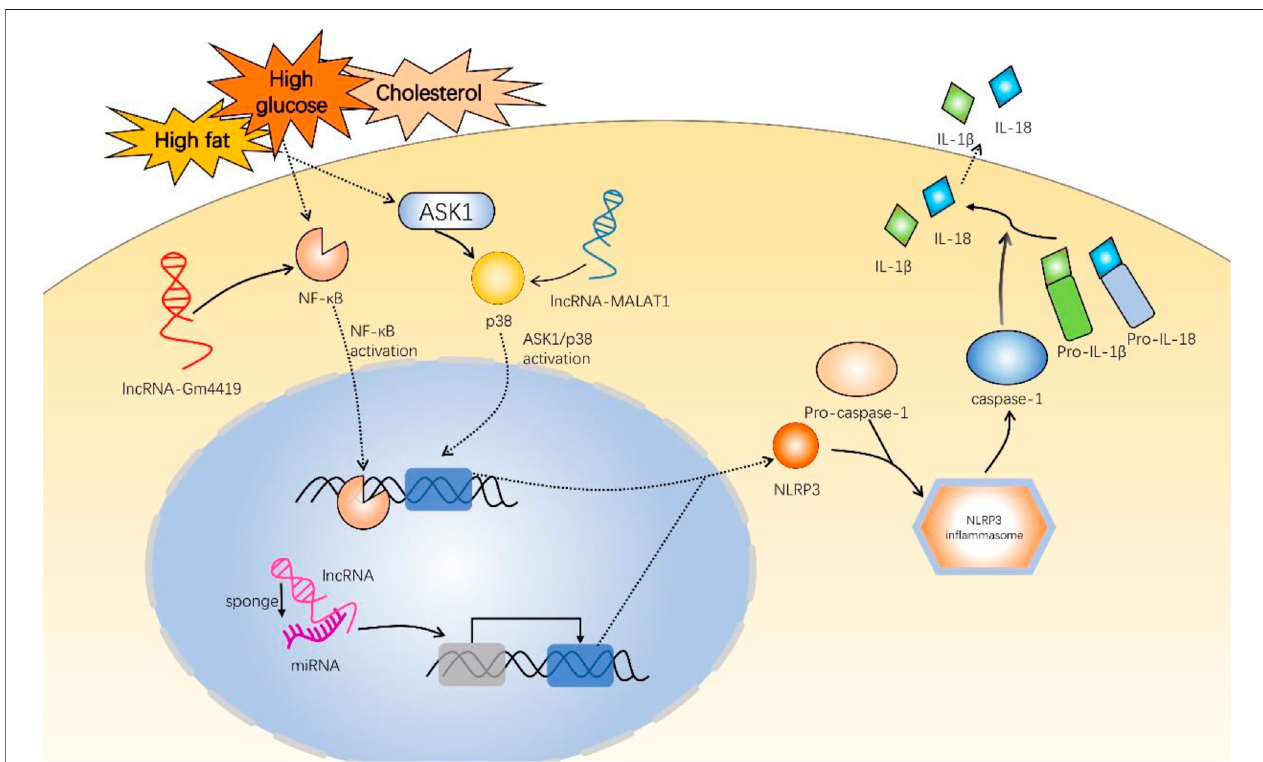
FIGURE 2 | Mechanisms of long non-coding RNAs involved in in fl ammatory responses of diabetic complications via NLRP3 in fl ammasome. These experiments used high-glucose induction to establish diabetic mouse models. LncRNA-Gm4419 activates NF- κ B pathway to upregulate NLRP3 expression in DN. LncRNA- MALAT1 activates ASK1/p38 pathway to upregulate NLRP3 in DR. In addition, most lncRNAs, such as ANRIL, Kcnq1ot1, NEAT1, HCP5, SNHG16, H19, and HCG18 promote or inhibit NLRP3 expression by sponging miRNA and regulating downstream target genes. NLRP3 and pro-caspase-1 are indispensable to NLRP3 in fl ammasome assembly. NLRP3 in fl ammasome activates pro-caspase-1 into caspase-1, promoting IL-1 β and IL-18 generation. NF- κ B, nuclear factor- κ B; ASK1, apoptosis signal-regulating kinase 1; MALAT1, metastasis-associated lung adenocarcinoma transcript 1; lncRNA, long non-coding RNA; miRNA, microRNA; ANRIL, antisense noncoding RNA in the INK4 locus; Kcnq1ot1, Kcnq1 overlapping transcript 1; NEAT1, nuclear-enriched abundant transcript 1; HCP5, HLA complex P5; SNHG16, small nucleolar RNA host gene 16; HCG18, HLA complex group 18.